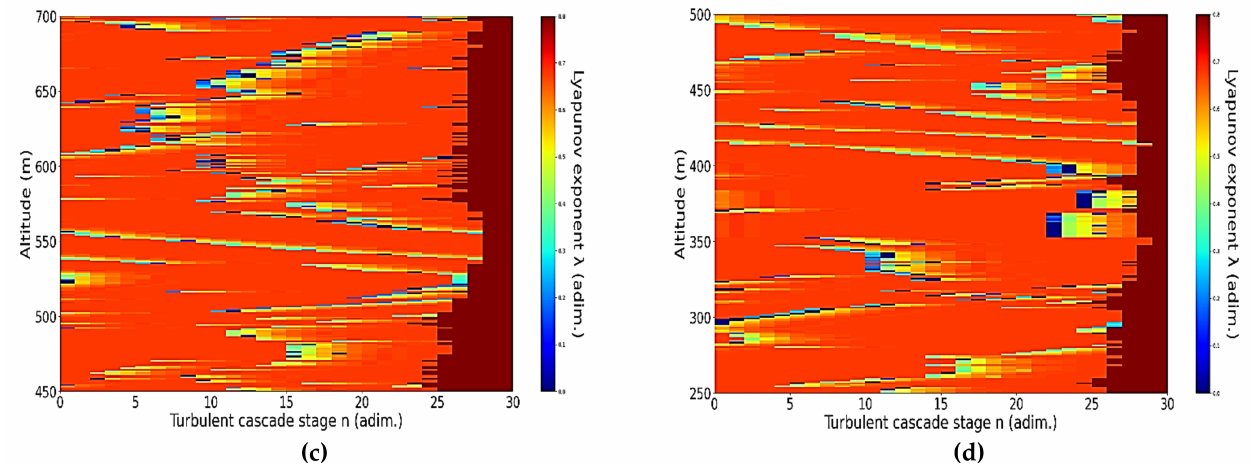
Figure 13. Lyapunov exponent per turbulent cascade stage colormap altitude plot: ( a ) 07 May 2018, first profile; ( b ) 21 April 2018, first profile; ( c ) 07 May 2018, first profile zoomed-in; ( d ) 21 April 2018, first profile zoomed-in.